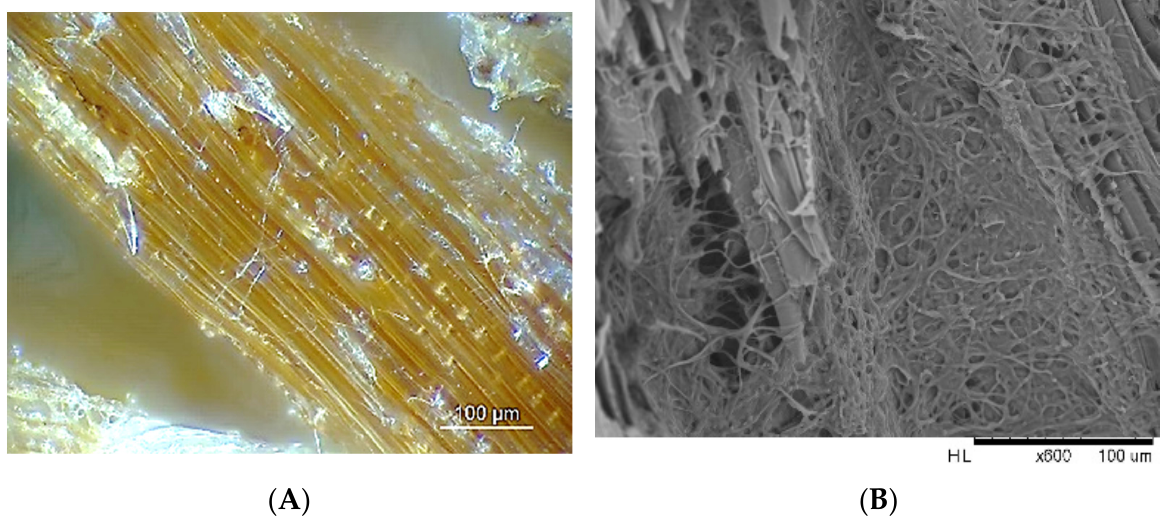
Figure 7. Microscopic monitoring of filamentous fungus growth during a bioremediation process: episcopy microscopy ( A ) and scanning electron microscopy ( B ), non-published data.